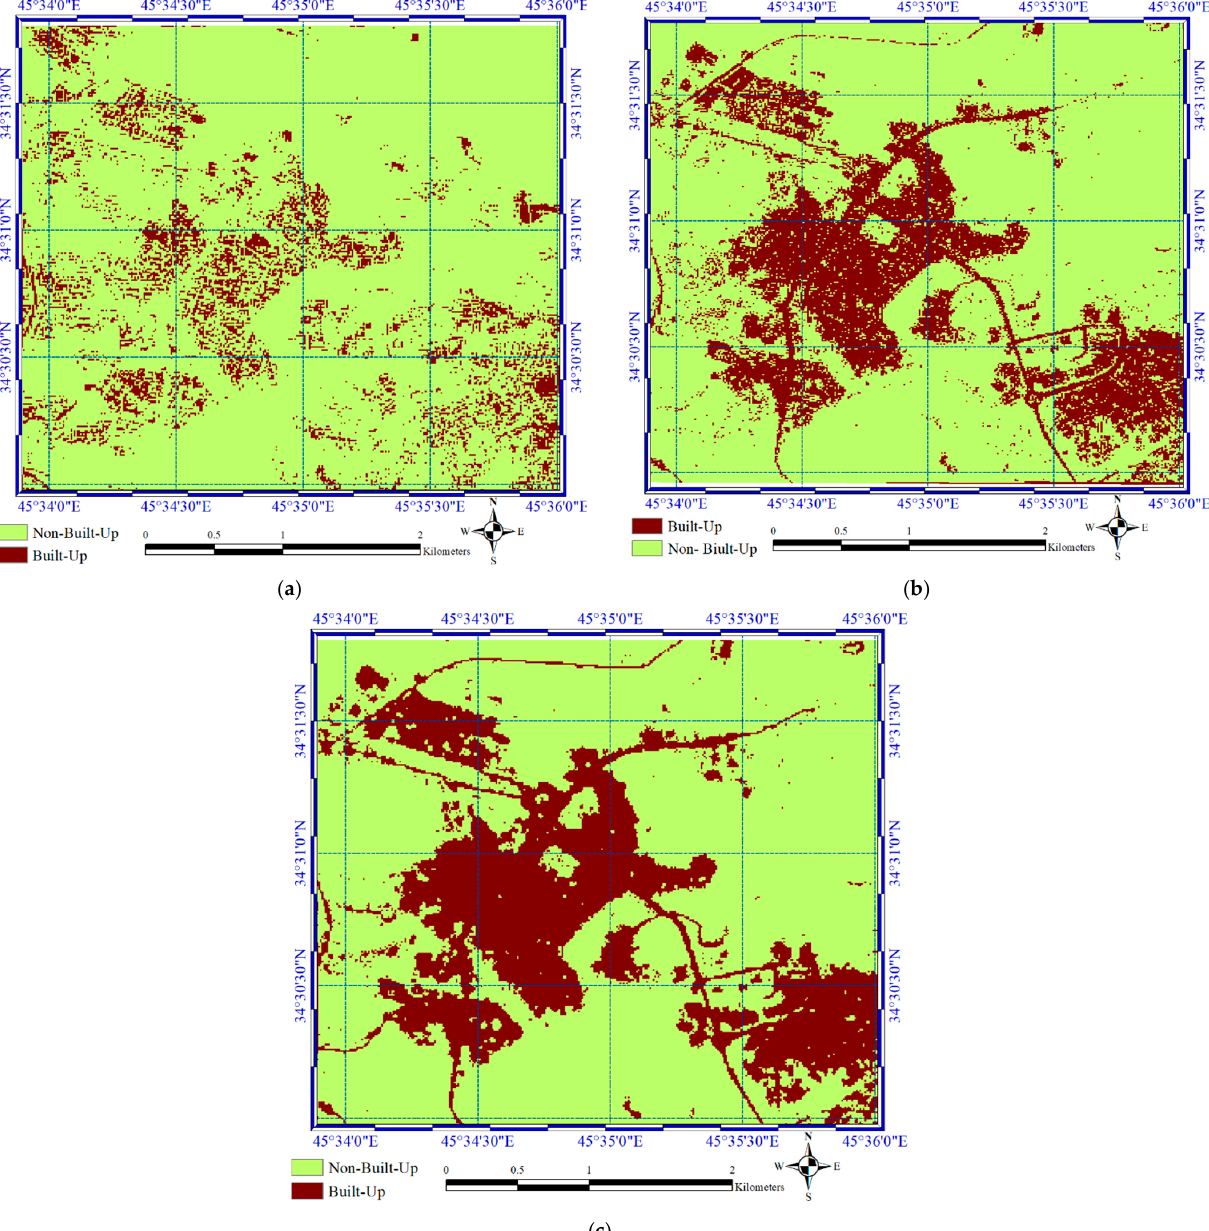
Figure 5. The result of built-up area detection on both datasets. ( a ) The ND-Based method in Qasr-Shirin, ( b ) Proposed method in Qasr-Shirin, and ( c ) Ground Truth of Qasr-Shirin.